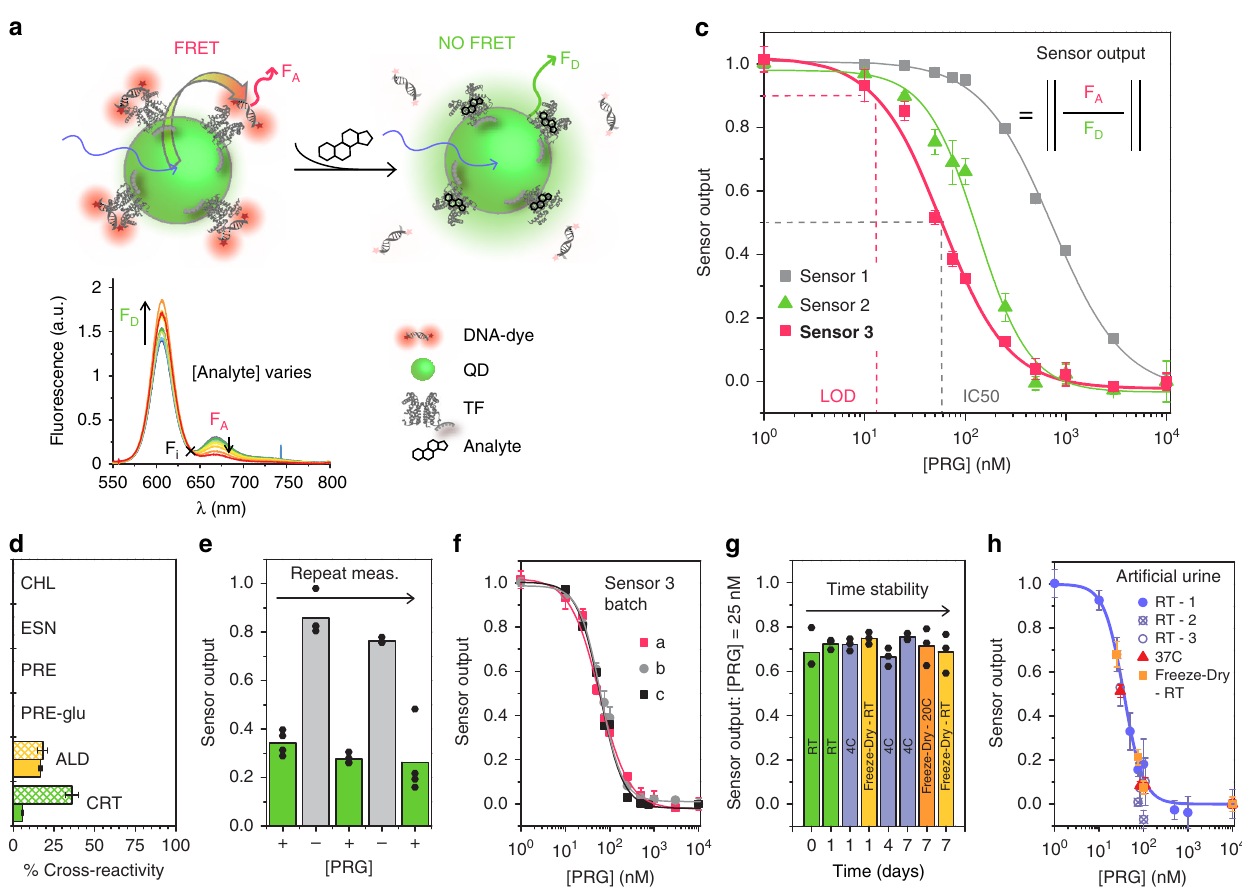
Fig. 3 Development and validation of an optical progesterone biosensor. a Biosensor scheme. b FRET occurs when TFs are bound to DNA resulting in less donor emission and increased acceptor (F A ). Sensor output is a normalized ratio of acceptor to donor emission. F i = iso fl uorescence point. c Progesterone sensor response. Sensor 1, sensor 2, and sensor 3 described in text. d Cross-reactivity to related steroids using sensor 3 with SRFT1 (cross- hatched) and SRTF1_MUT1 (solid). e Repeated cycles of progesterone exposure using sensor 3. f Reproducibility of different manufactured batches. Batch a and b are derived from 2 different batches of QDs two SRTF1 puri fi cations. g Storage stability of sensor 3 in the dark: room temperature (RT), 4 °C, or lyophilized and stored at − 20 °C or at RT. h Sensor 3 in arti fi cial urine: arti fi cial urine (containing PRG) added at RT or at 37 °C or sensor lyophilized recovered in arti fi cial urine and PRG added in arti fi cial urine. Sensor 3 at RT-1 was tested at 10 different PRG conditions. The fi t is of the curve (blue line) is only for this sensor output. Sensors 3 at RT-2, RT-3, 37 °C and freeze-dry were measured at 5 different PRG concentrations. c , f , h Error bars are standard errors over three experiments. Data for reported means in panels c , e , f , g , and h are available in the Source Data fi